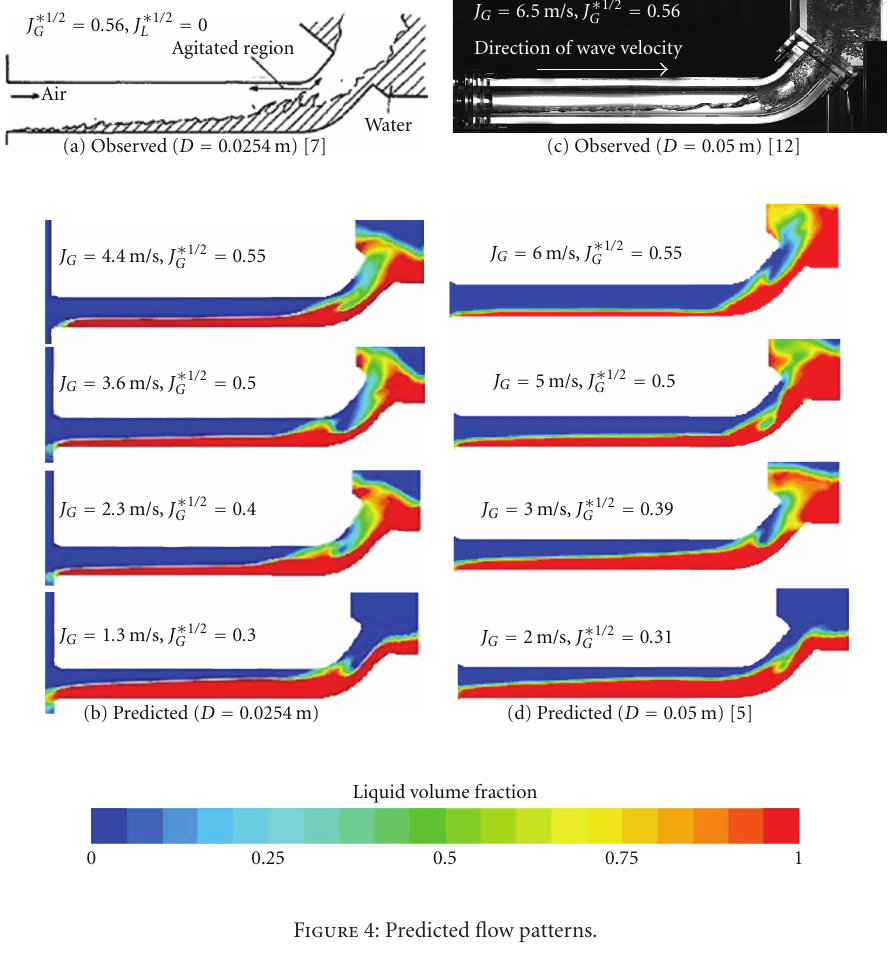
Figure 4: Predicted flow patterns.